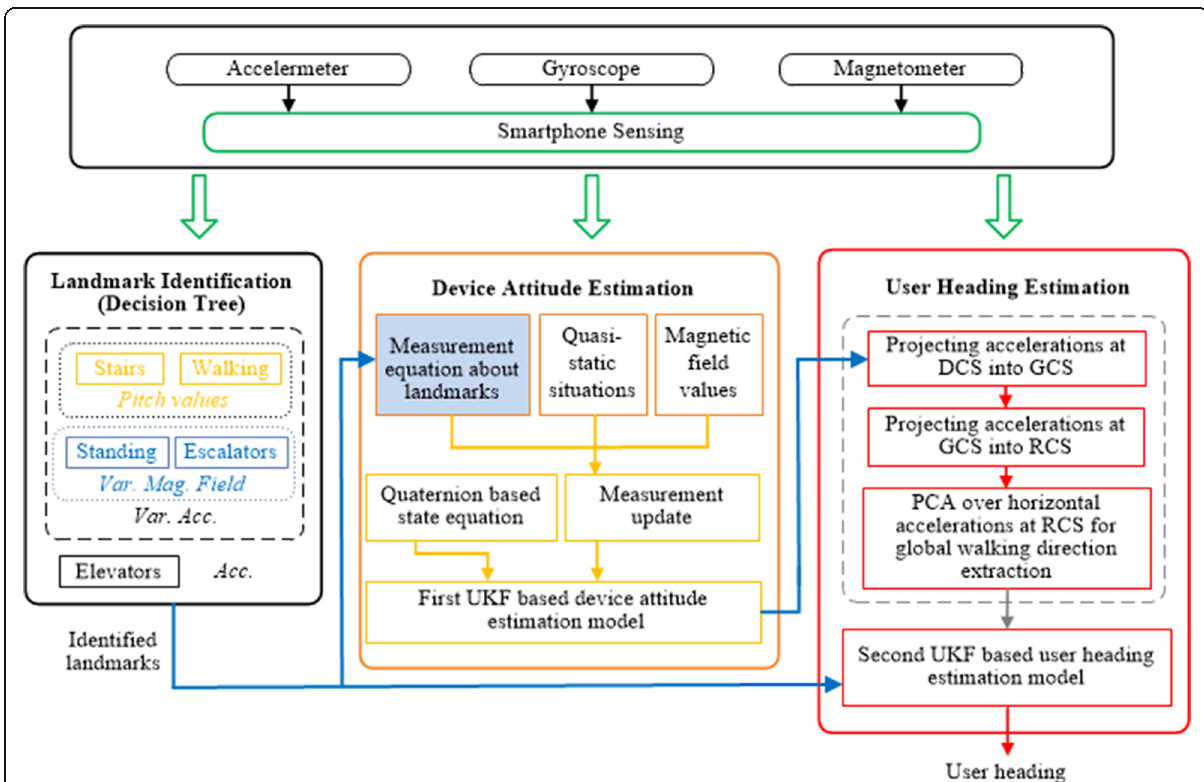
Fig. 1 Overview of the proposed user heading estimation approach fusing inertial sensors and